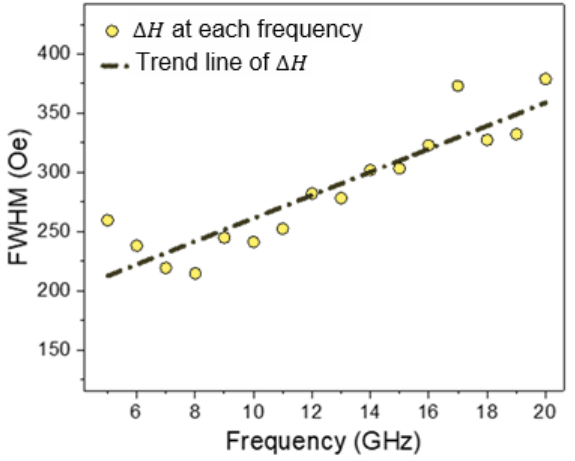
Figure 7. FMR analysis for sample S1 (FWHM vs. frequency).